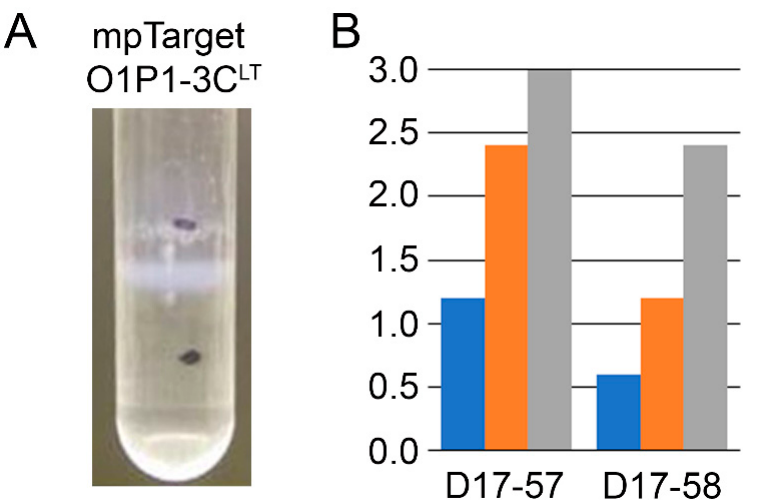
Figure 3. Antigen extracted from cells transfected with mpTarget O1P1-3C LT plasmid was found to ( A ) sediment at the appropriate density using a cesium chloride density gradient and ( B ) produce VNTs in two guinea pigs, ear tags D17-57 and D17-58, inoculated in a non-challenge study at 7 (blue) and 14 (orange) days post-vaccination. VNTs were further enhanced at 28 days post-vaccination (gray) following a boost at day 21.